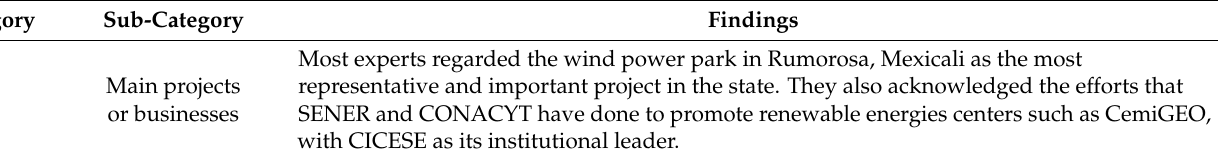
Table 5. Renewable experts’ perspective on the renewable energies industry sector in Baja